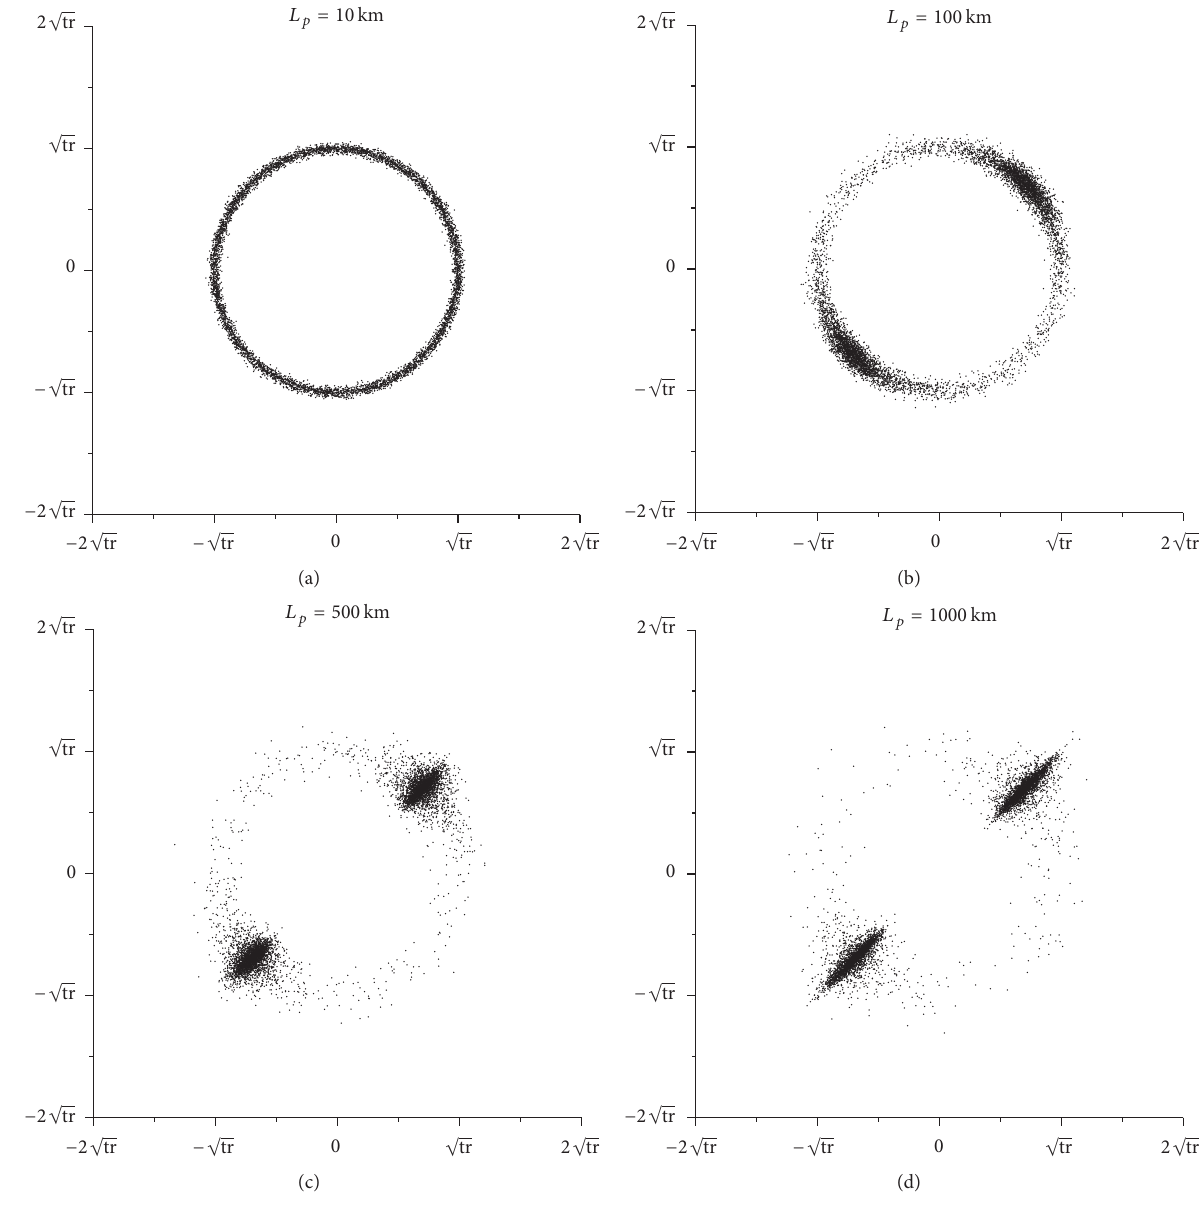
Figure 4: Schematic view of the concentration of 6400 samples of a random vector 𝜀 𝑏 ∼ N (0, B ) on a spherical shell (or a part of it) of constant radius √ tr ( B )(= √𝑛) and variable thickness (1/√2)(√ tr ( B )/√𝑑 ef ( B ))(= (1/√2)(√𝑛/√𝑑 ef ( B ))) in function of the length-scale.